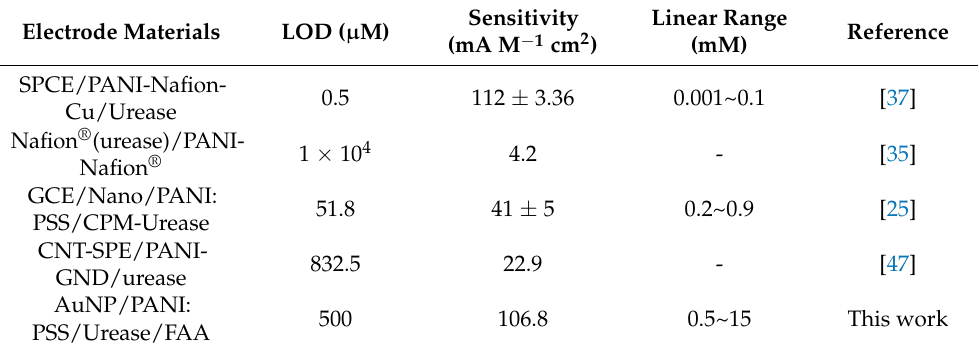
Figure 4. ( a ) Schematic diagram of the detection principle of PANI: PSS-urease-based urea electrode ( b ) cyclic voltammetric curves of urea electrodes in urea solutions of different concentrations ( c ) calibration curves of urea electrodes; ( d ) resistance of urea electrodes to cations (In a 0.01 M PBS solution, sequentially add 5 mM urea, 5 mM NH 4 Cl, 5 mM KCl, 5 mM NaCl, 5 mM CaCl 2 , and 5 mM MgCl 2 ); ( e ) resistance of urea electrodes to metabolites (In a 0.01 M PBS solution, sequentially add 5 mM urea, 50 µ M glucose, 5 mM CRE, 150 µ M UA, and 100 µ M AA). Table 2. Comparison of electrode properties for urea